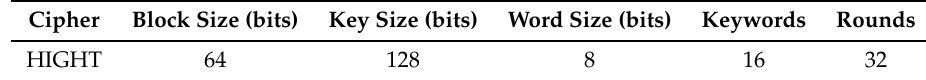
Table 2. Parameters of